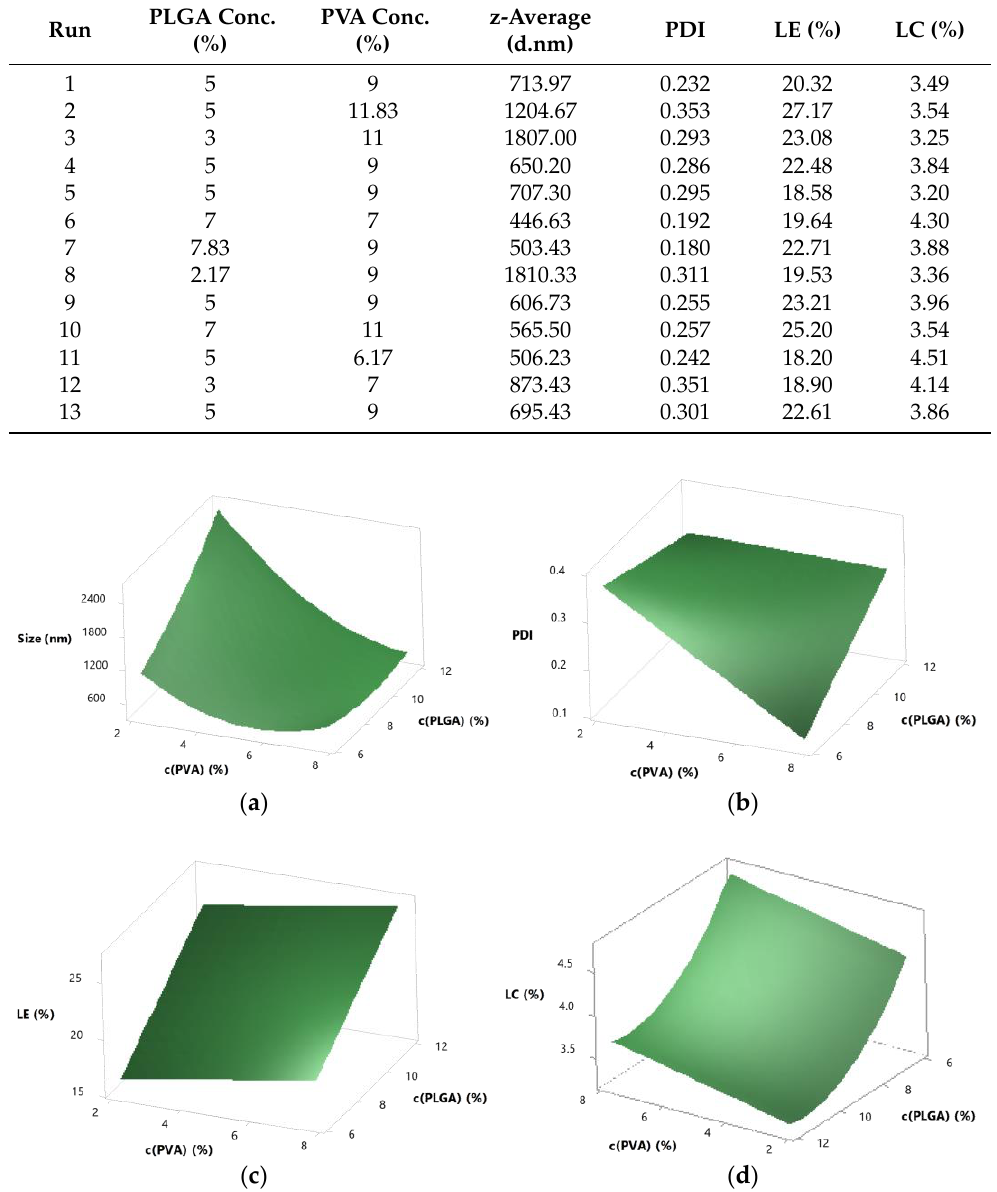
Table 6. Results of central composite response surface design.